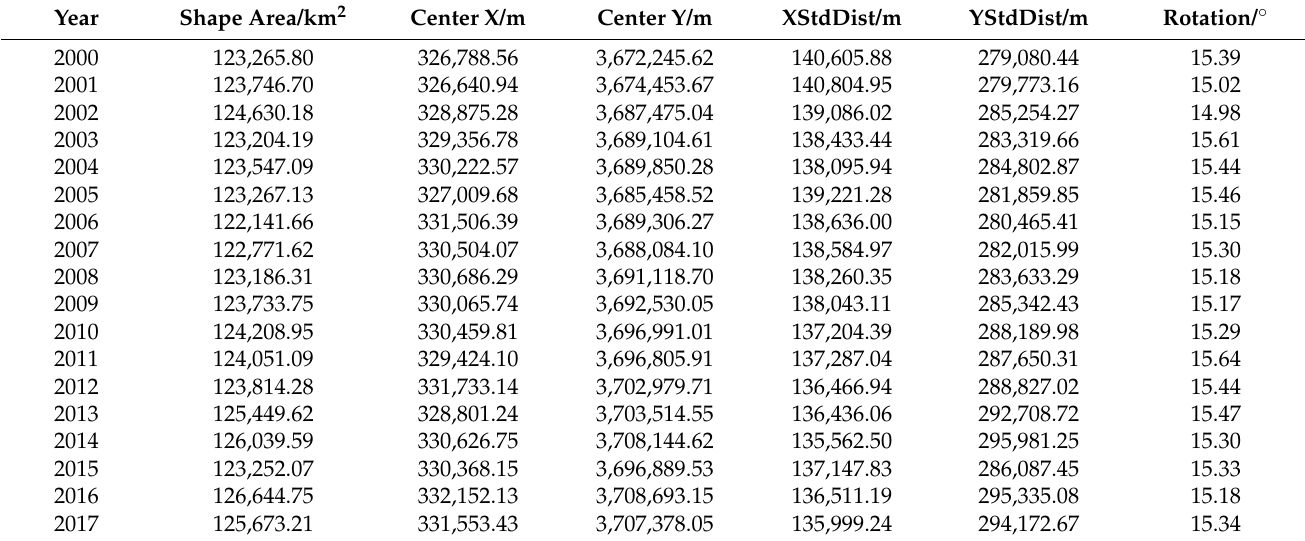
Table 1. Changes in the SDE of carbon